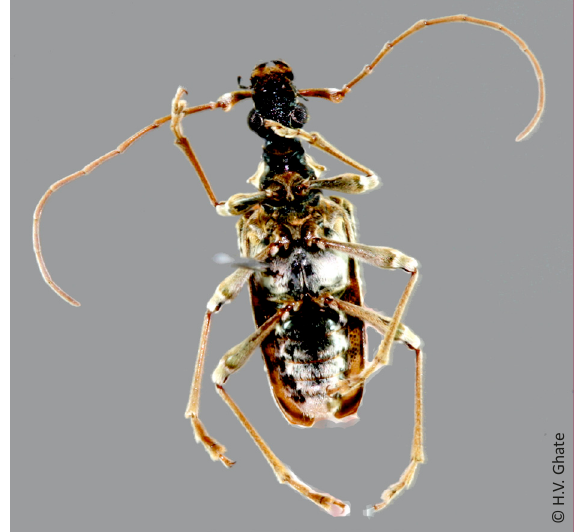
Image 13. Ventral view of